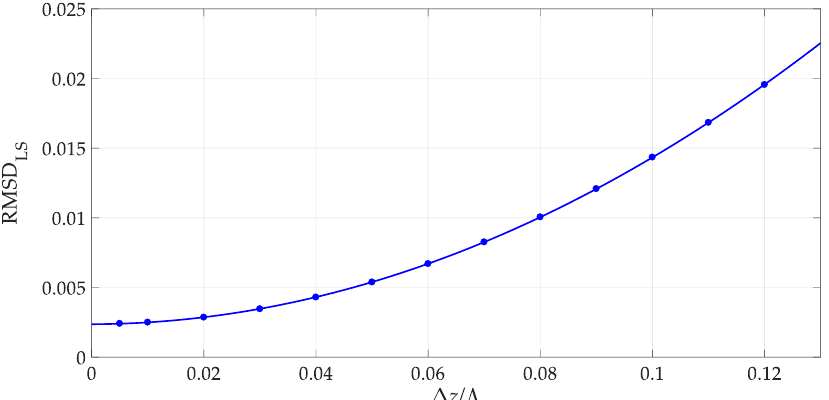
Figure 6. Values of the root-mean-square deviation (RMSD) of the homogeneous FBG spectrum modeled using the LS method (blue dots) depending on the partition interval ∆ z , and their approximation (blue solid line).